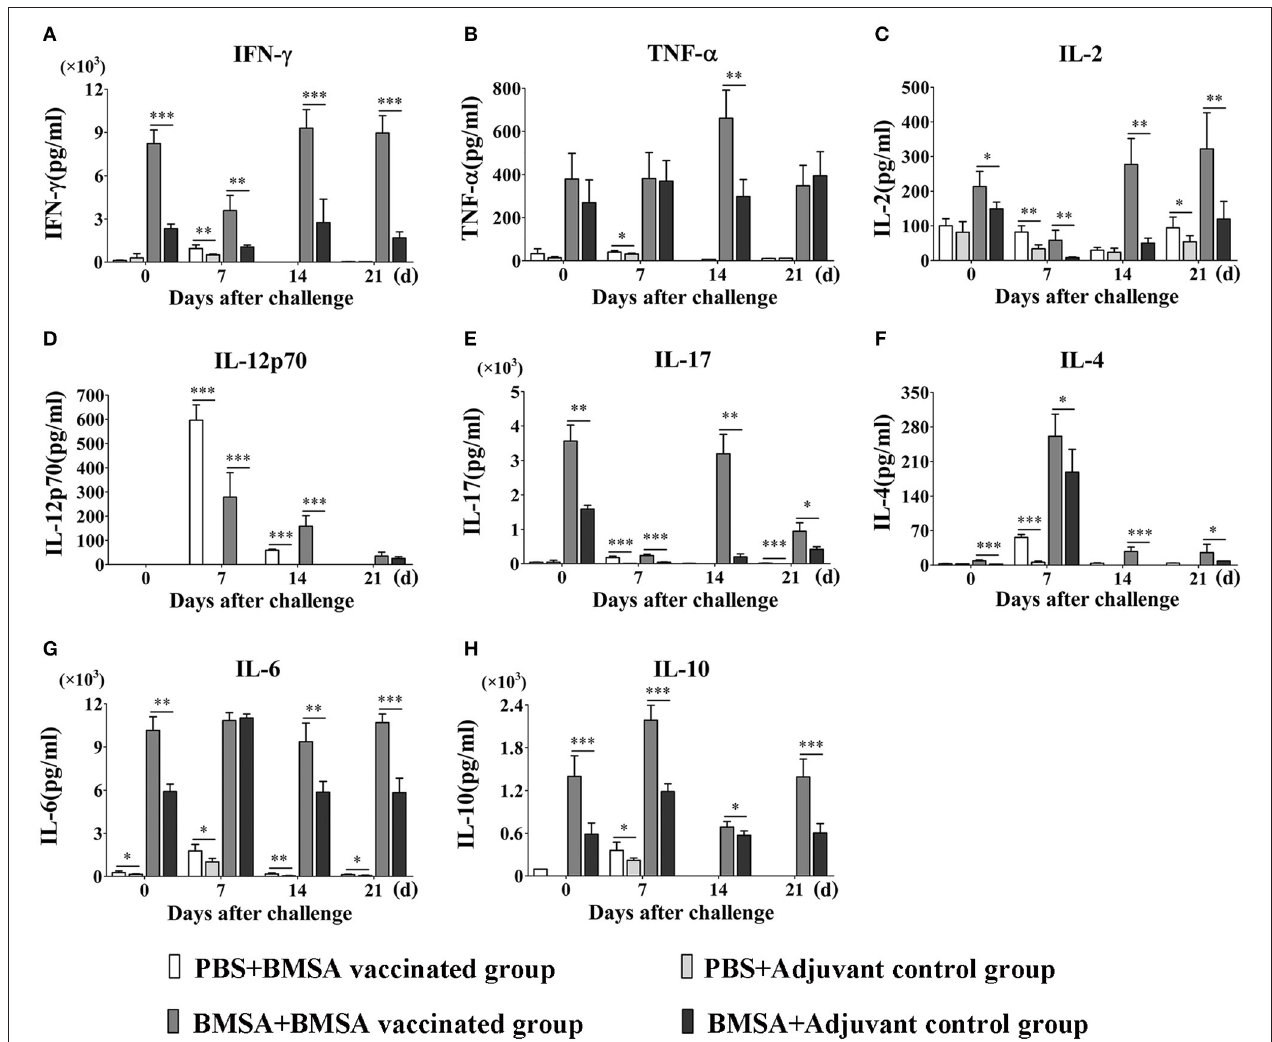
FIGURE 5 | Cytokine levels in culture supernatants of splenocytes. BALB/c mice in the BMSA vaccinated or adjuvant control groups were followed by a challenge with 1 × 10 7 erythrocytes infected with B. microti and were sampled on days 0, 7, 14, and 21. Splenocytes were cultured in vitro and stimulated with PBS, BMSA, or ConA (data not shown). (A–H) The levels of IFN- γ , TNF- α , IL-2, IL-12p70, IL-17, IL-4, IL-6, and IL-10 in culture supernatants were determined using a Mouse Cytokine/Chemokine Magnetic Bead Panel. The data represent two individual experiments (* p < 0.05; ** p < 0.01; *** p <